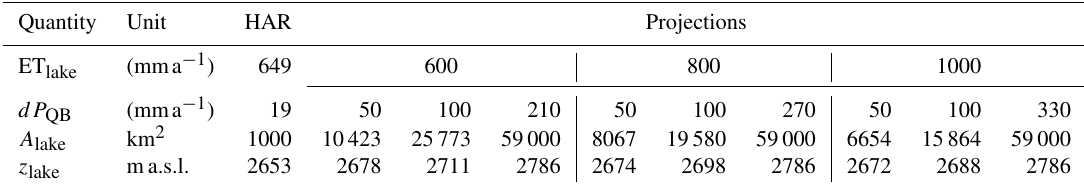
Figure 5. Illustration of the maximum extent of the mega-lake system in the Qaidam Basin (QB) of approximately 59000km 2 as reported by Chen and Bowler (1986) using the present-day model topography of the HAR 10km data set for accumulation of net precipitation in the QB and subsequent runoff originating from land in areas at or below 2786ma.s.l. (marked in cyan). Black line: boundary of the QB (Lehner and Grill, 2013). Blue: present-day lake extent (1000km 2 ) as represented in the HAR 10km data set. Topographic shading is based on DEM data from the SRTM. Table 3. Mean annual rate of lake evaporation ET lake , change in mean annual precipitation dP QB with respect to present-day precipitation (HAR 10km; 200mma − 1 ), lake extent A lake , and approximate altitude of lake level z lake for equilibrium lake states in the Qaidam Basin (QB) as computed by a semi-empirical model (cf. R source code in the Supplement). Values in column “HAR” are taken from the HAR 10km data set and represent mean annual values for the hydrological years from 2001 to 2014. Table 3 also displays a combination of three projections for ET lake (600, 800, and 1000mma − 1 ) and two projections for dP QB (50 and 100mma − 1 ). For each of the three projections for ET lake , the value for dP QB is shown that would sustain the maximum extent of the mega-lake system in the QB (see Fig. 5). Values for z lake have been computed from the HAR 10km model topography by choosing the value that produces a lake extent closest to the equilibrium lake extent as computed by the semi-empirical